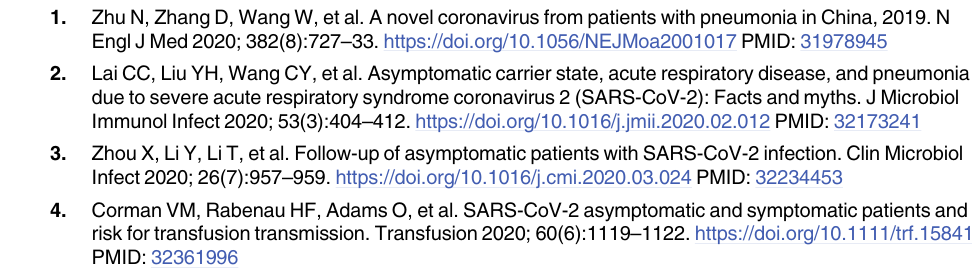
S5 Table. Laboratory characteristics of 4 patients with re-positive NAT